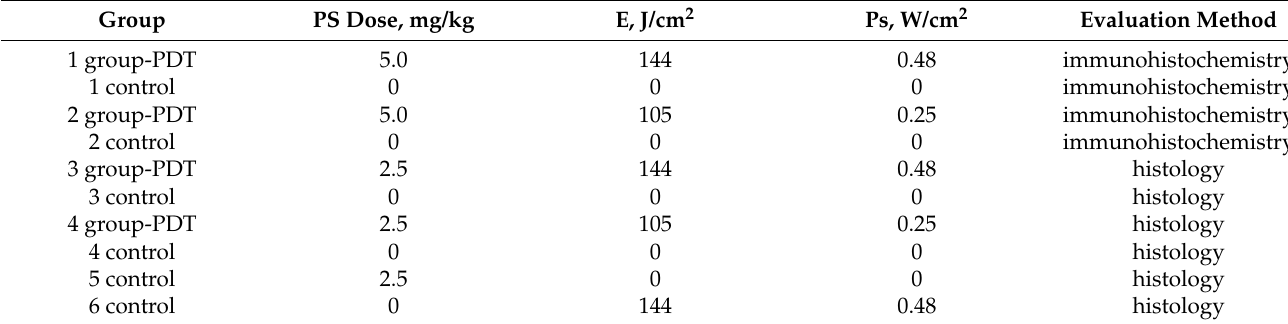
Table 2. Experiment